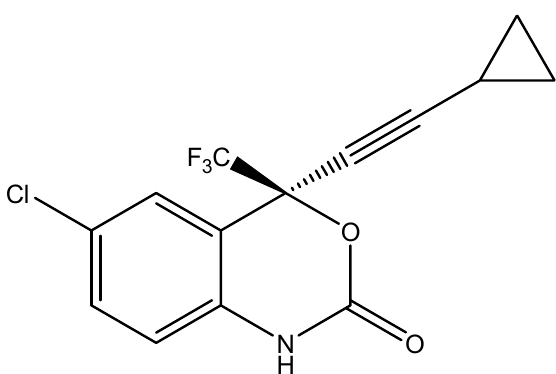
= 315.7) 14 H 9 ClF 3 NO 2 , MW